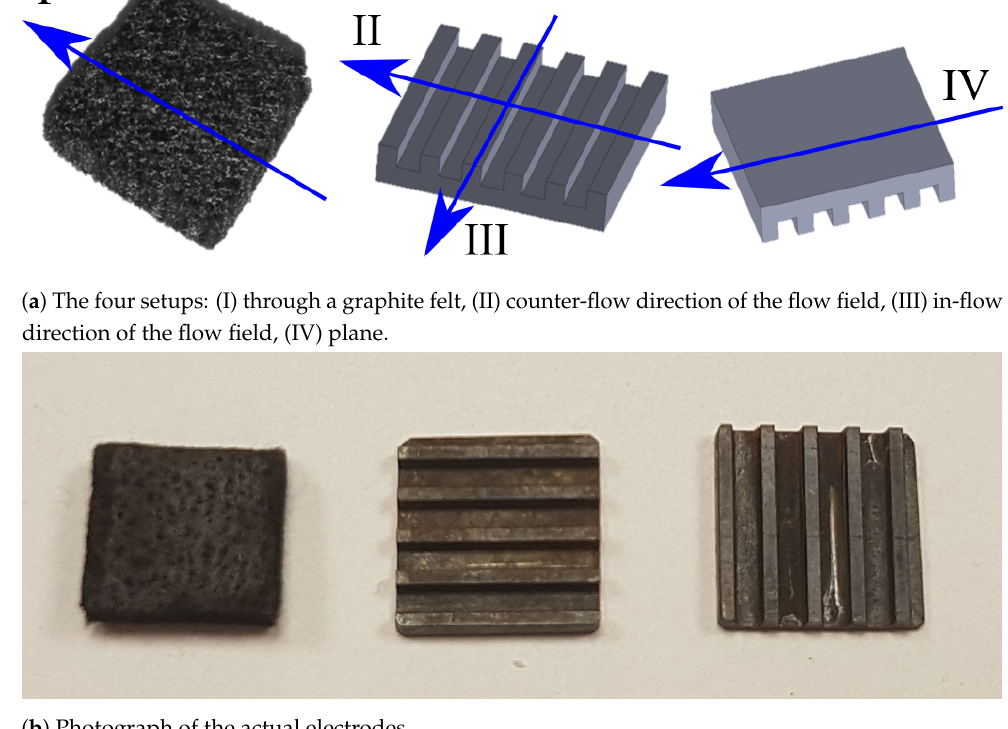
Figure 3. Four different graphite electrodes setups are used in the